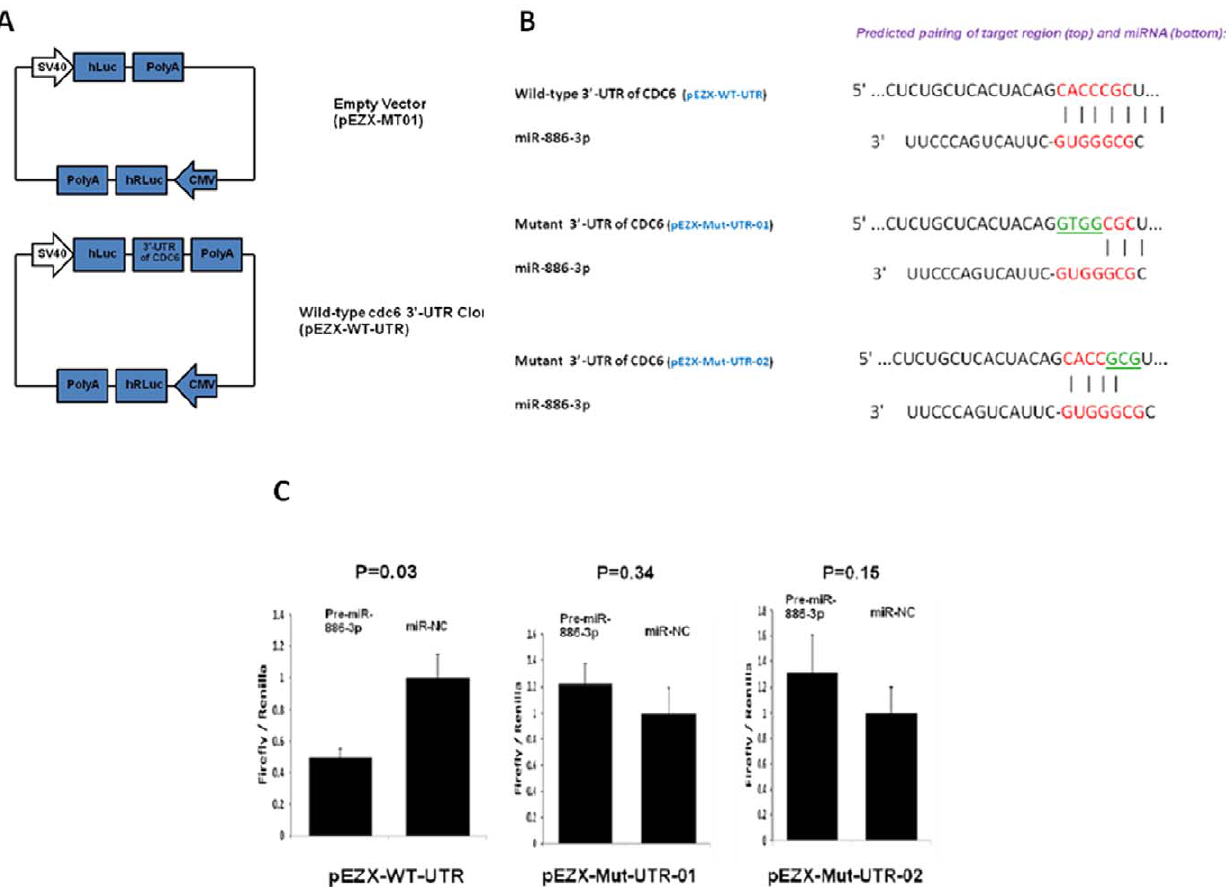
Figure 5. Western blot analysis of CDC6 protein expression with pre-miR-886-3p overexpression in TPC-1 cells. A ) Representative western blot image of CDC6 protein expression at 72 hours after transfection with pre-miR-886-3p as compared to negative control (miR-NC). B ) Band densitometry quantification of CDC6 protein expression. The software ImageJ (Maryland, USA) was used for densitometric analysis of western blots.